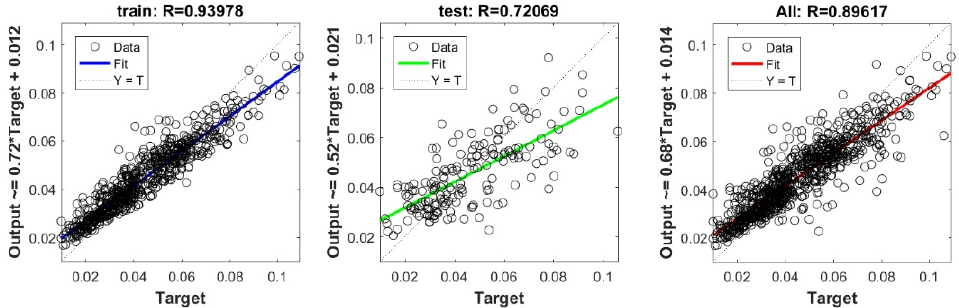
Figure A8. Scatter plots between target and output value by the FS-RF model.